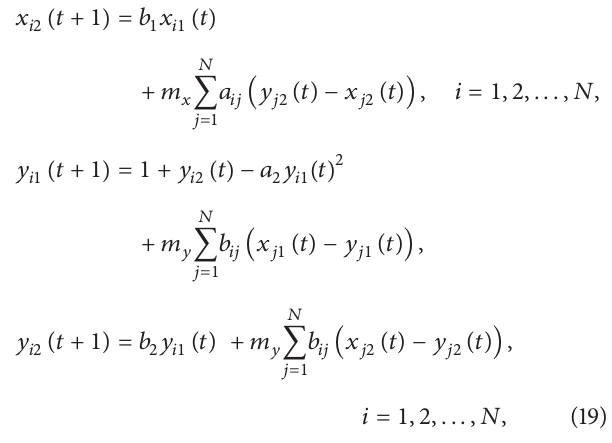
Figure 2: The plots show 𝐸 𝑥 , 𝐸 𝑦 , and 𝐸 𝑁 = 10 and 𝑚 synchronization simultaneously happen.